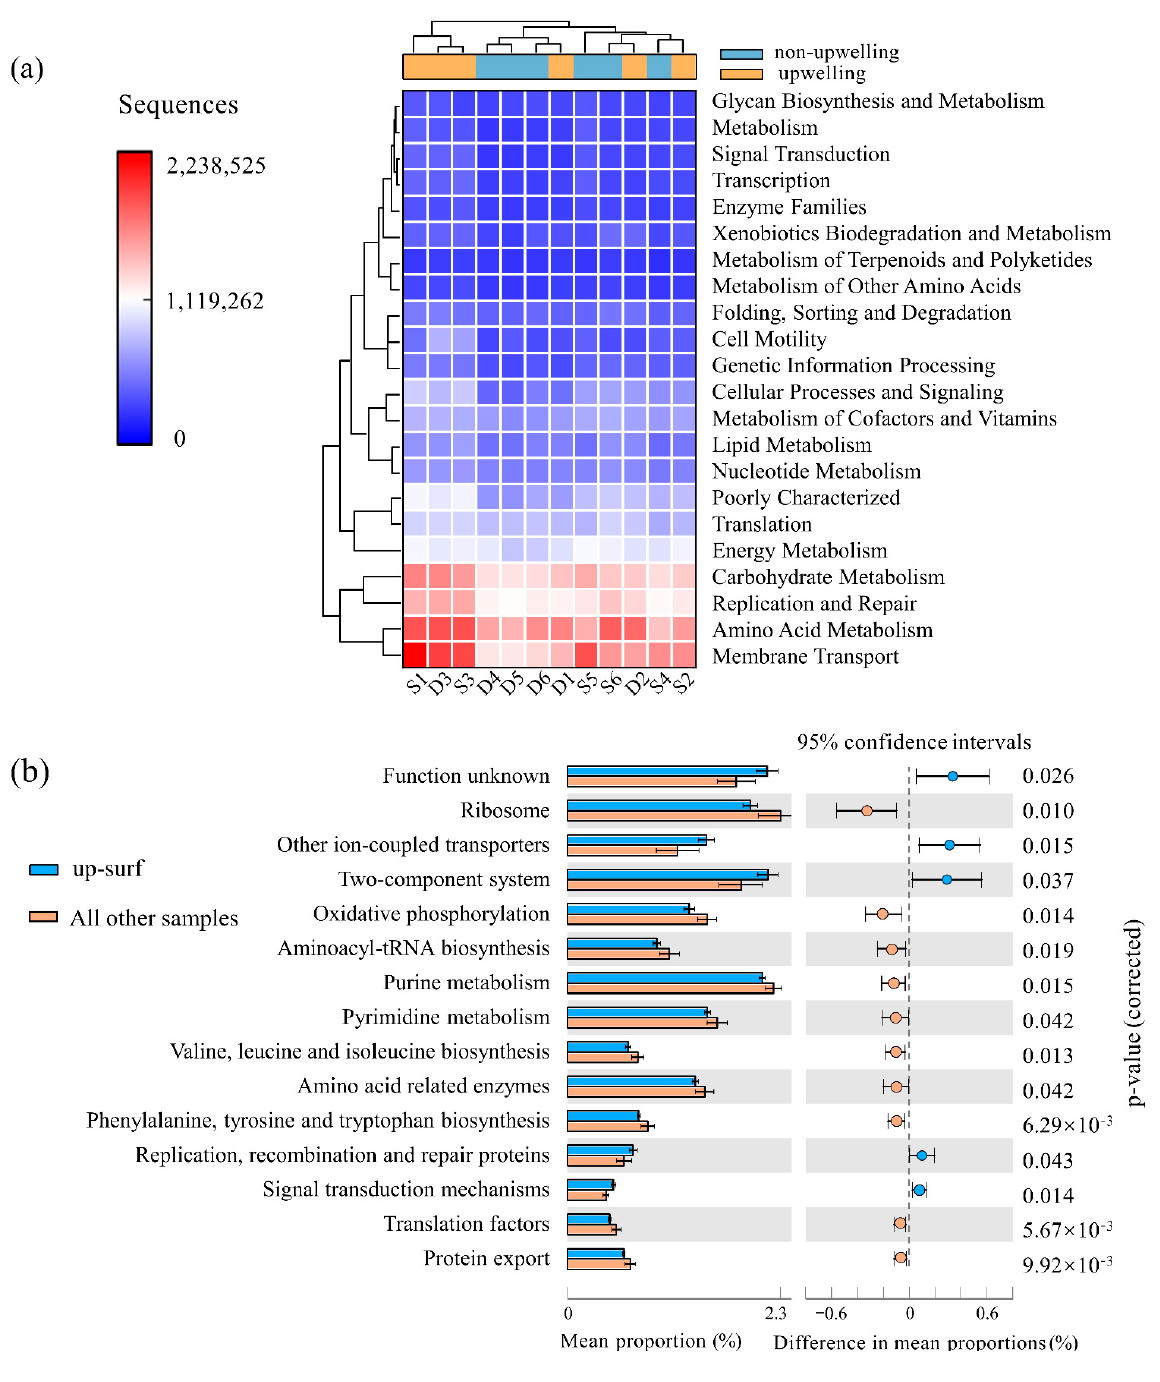
Figure 4. Functional predictions of bacterioplankton communities in different samples. ( a ) Heatmap showing the absolute abundance of the major gene families at KEGG level 2, and ( b ) extended error bar plot showing the significant dissimilarity of the metabolic pathways at KEGG level 3 between the up-surf area and all other samples. Surface water and deep water are represented by S and D, respectively. The number following S or D indicates the sampling station.